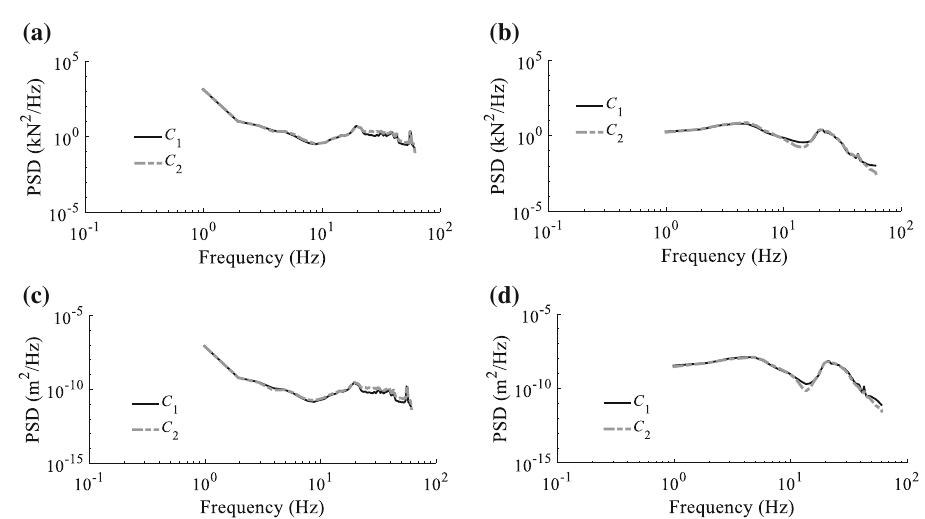
Fig. 12 Average PSD comparison between C 1 and C 2 ( a wheel–rail vertical force; b wheel–rail lateral force; c vertical displacement of the rail; d lateral displacement of the rail)